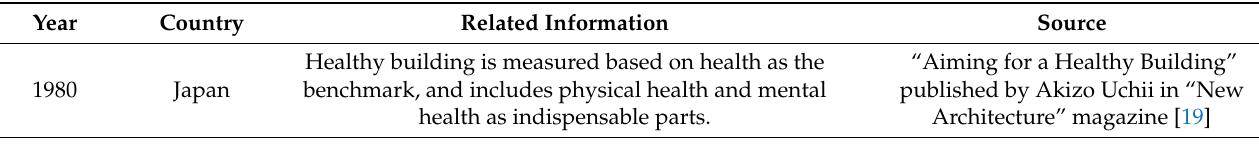
Table 1. Definitions of healthy buildings in the